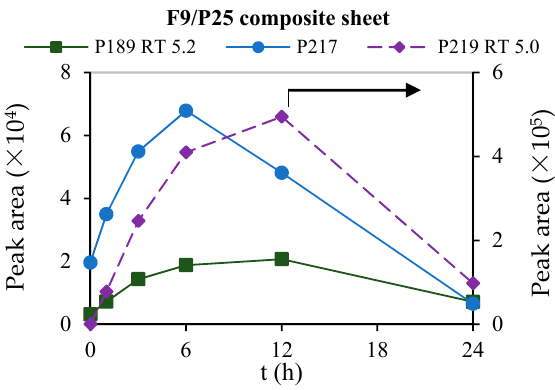
Figure 7. Changes in the peak areas of the major intermediates over time in ultrapure water when crotamiton was photocatalytically degraded using the F9/P25 composite sheet ( C 0 = 10 mg/L). The squares are P189 (retention time 5.2 min) and the circles are P217. The diamonds with a dashed line are P219 (retention time 5.0 min, secondary y -axis).